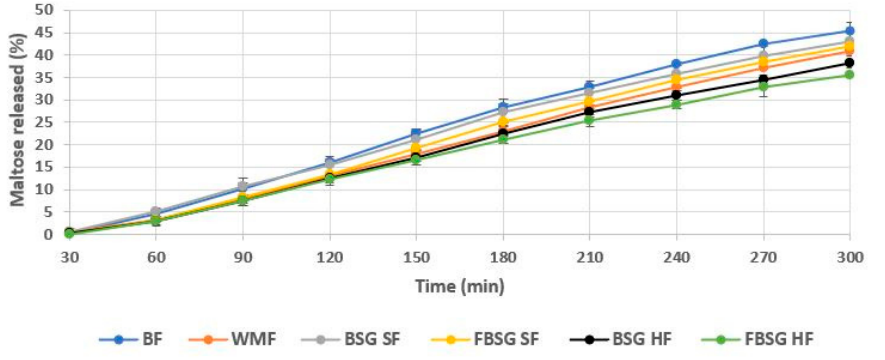
Figure 4. Comparison of the release of maltose over time from baked bread samples. BF and WMF denote “baker’s flour” and “wholemeal flour” breads, respectively. BSG and FBSG indicate “brewers’ spent grain” and “fermented brewers’ spent grain breads”, respectively. SF denotes “source of fibre addition level” and HF represents “high in fibre addition level”. Graphs show mean values of duplicate samples with standard deviations represented as error